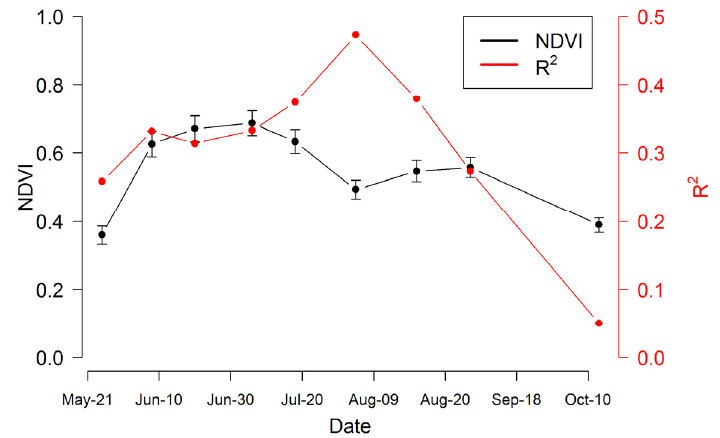
Figure 8. Time series of NDVI (black line) and R 2 of the NDVI-species richness regression (red line) over the growing season in 2014. NDVI was the average value (±SEM) of all the plots on each sampling date.